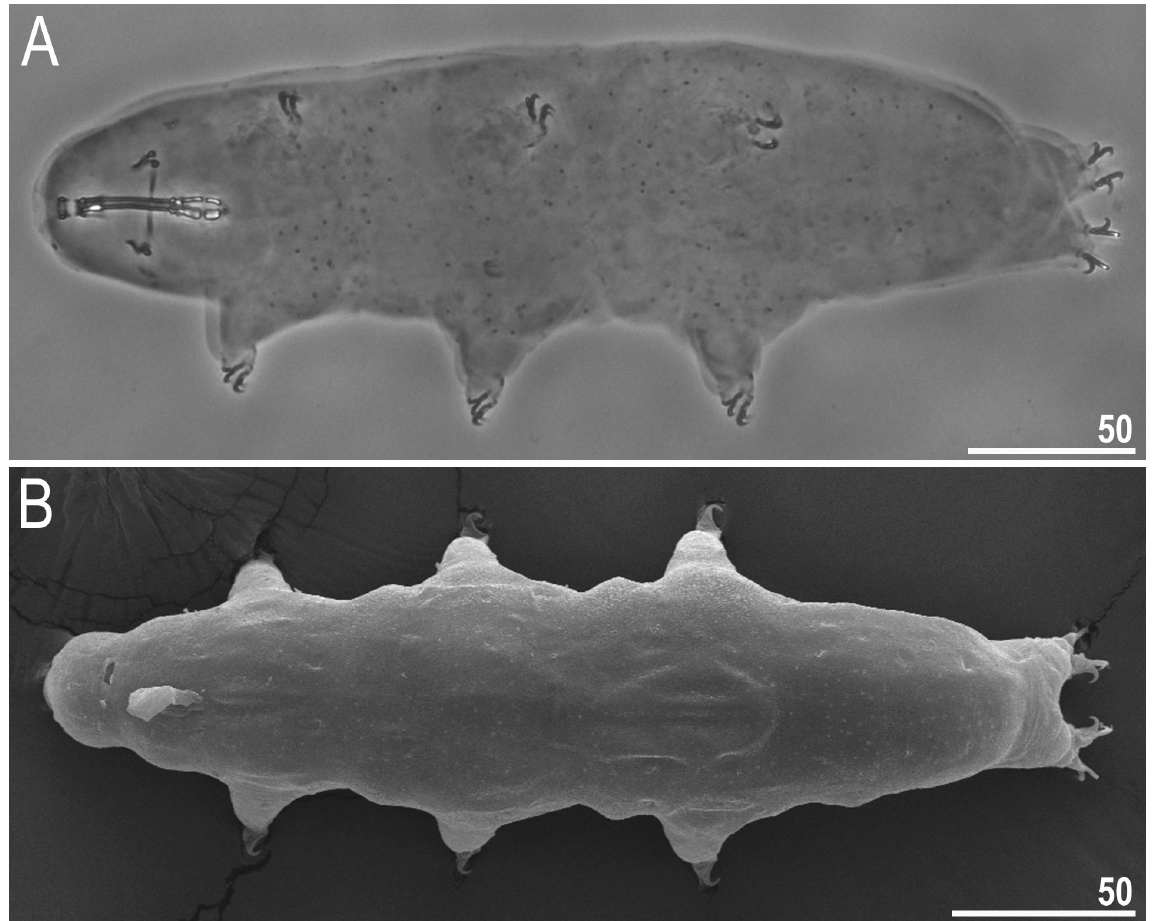
Fig. 1. Macrobiotus canaricus sp. nov., holotype, habitus. A . Dorso-ventral projection (Hoyer’s medium, PCM). B . Dorsal view under SEM. Scale bars in